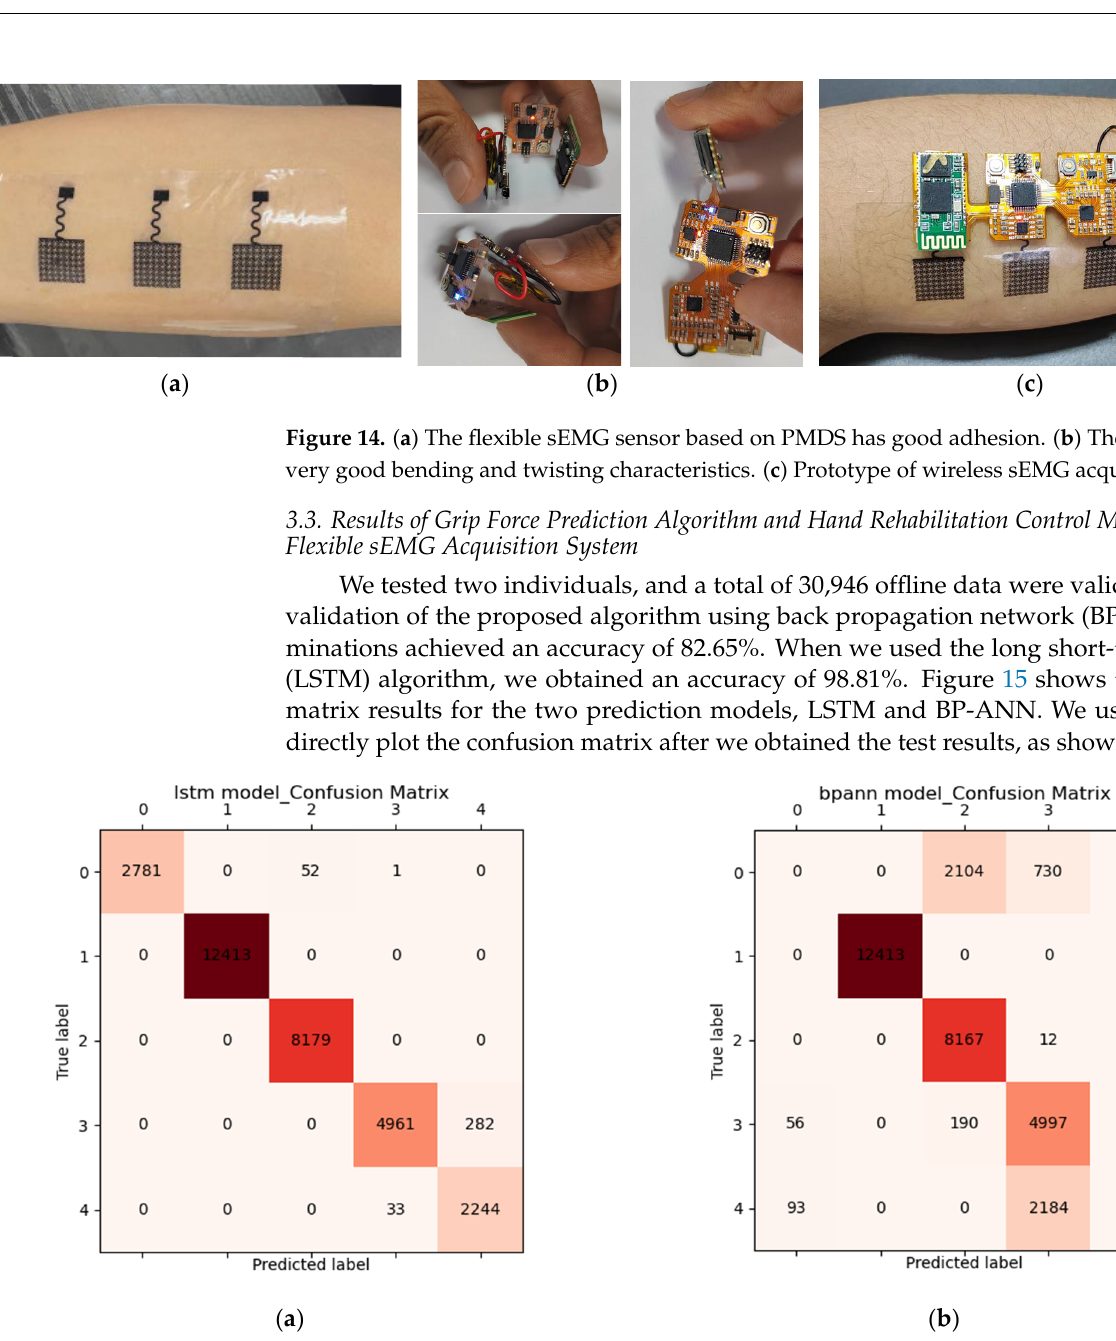
Figure 15. Confusion matrix for different types of prediction models. ( a ) Classification prediction model based on LSTM algorithm. ( b ) Classification prediction model based on BP-ANN algorithm.